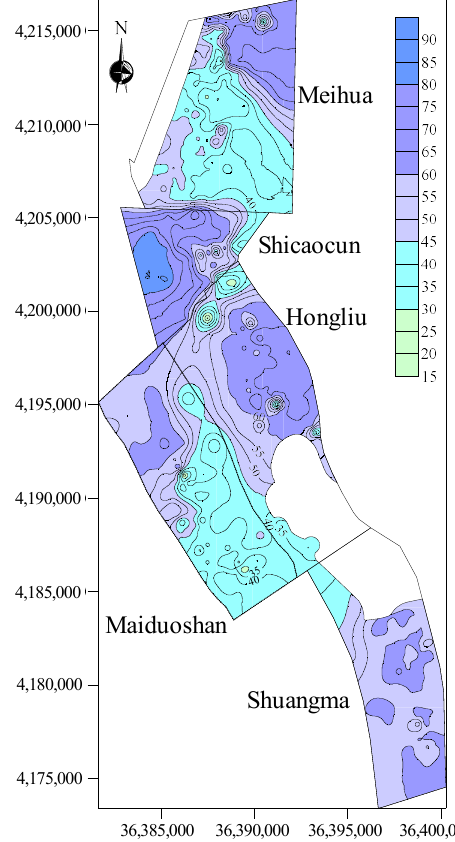
Figure 9. Contour map of the development height of the roof water-conducting fracture zone of the main coal seam in the study area after correction.